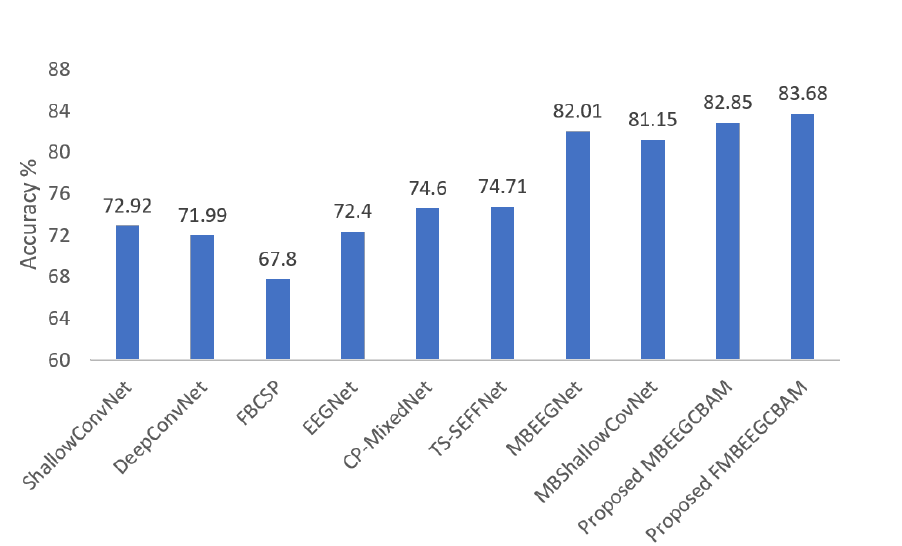
Figure 7. Average classification accuracy on the BCI-IV2a dataset. The methods compared are ShallowConvNet [18] , DeepConvNet [18] , FBCSP [25] , EEGNet [27] , CP-MixedNet [34] , TS-SEFFNet [37] , MBEEGNet [40] , MBShallowConvNet [40] , the proposed MBEEGCBAM, and the proposed FMBEEGCBAM.